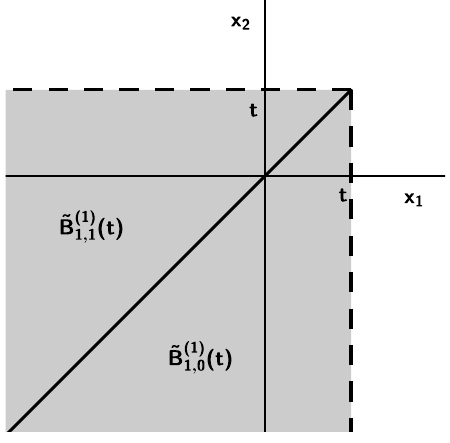
Figure 10: Disjoint decomposition of A 2 2 ( t ) for t > 0